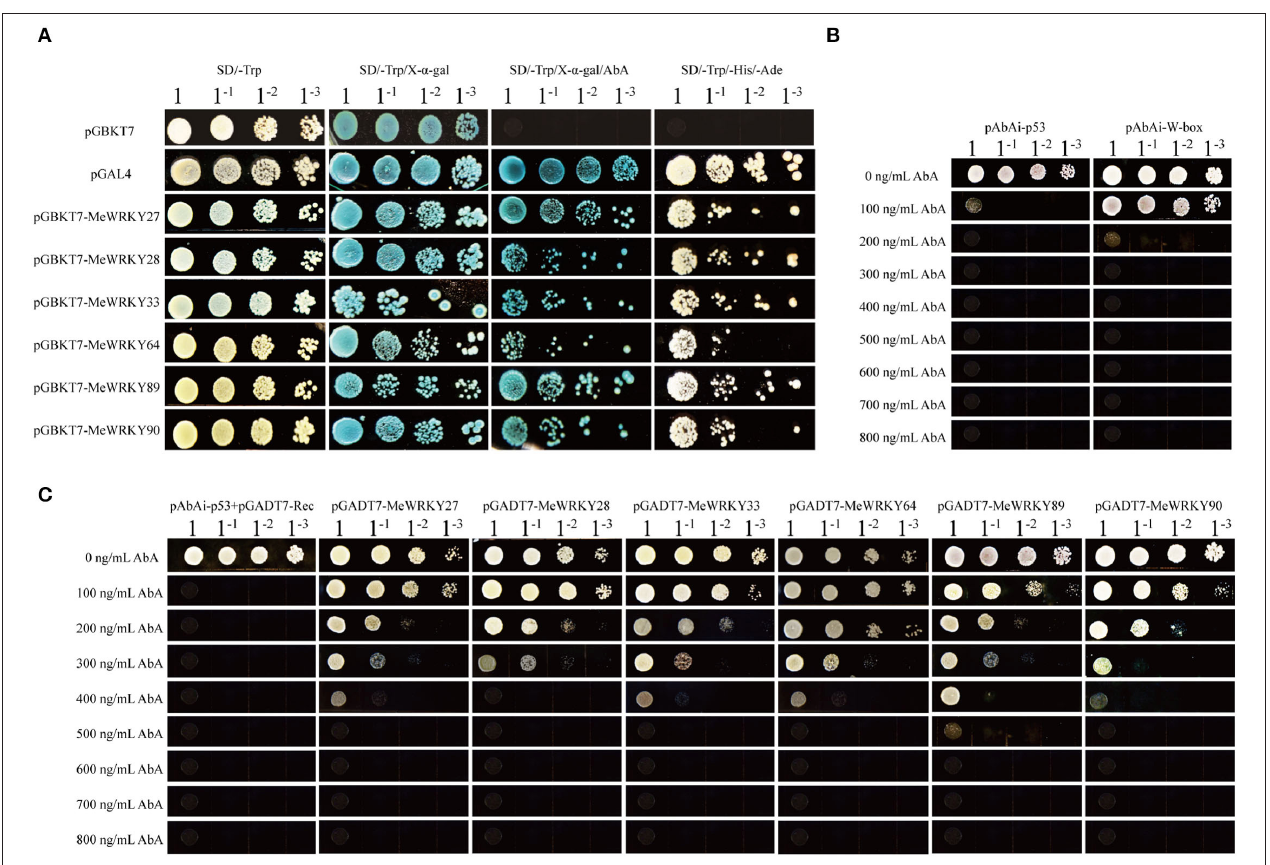
FIGURE 6 | MeWRKY IIas are typical WRKY transcription factor. (A) Self-activation assay of MeWRKY IIas. (B) Determination of the minimal inhibitory concentration of AbA for pABAi-W-box. (C) Interaction tests between MeWRKY IIas and W-box by